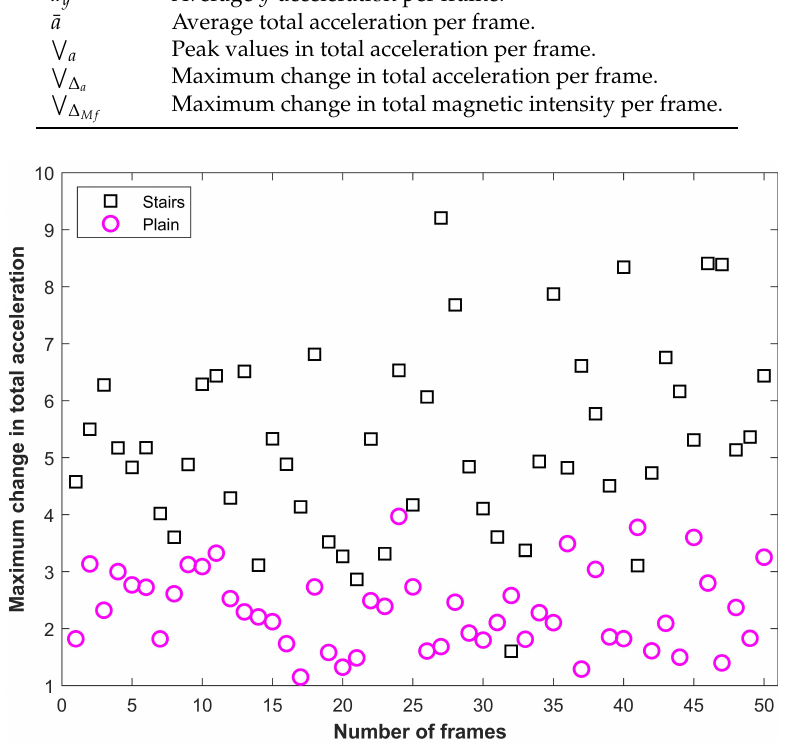
Figure 12. Peak values in total